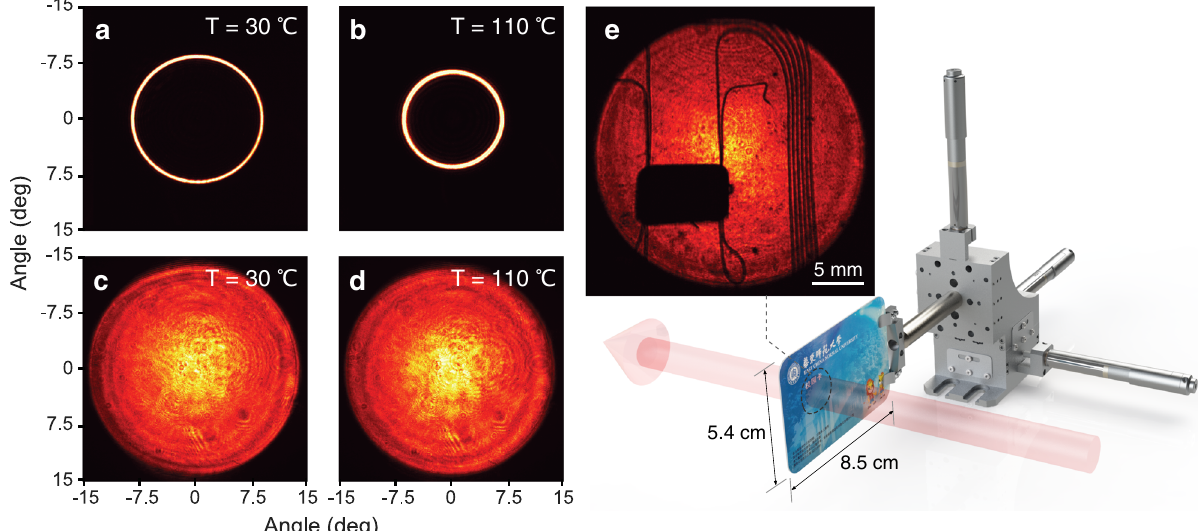
Fig. 4 Wide- fi eld MIR imaging performances. a , b Recorded fi eld of view for the conventional upconversion imaging with a PPLN at two different temperatures. c , d Wide- fi eld performance for the imaging scheme with a CPLN crystal, which indicates a robust immunity to the temperature variation. e Transmissive imaging for a campus ID card. The embedded chip and mental wires can be clearly identi fi ed. A video is recorded in Supplementary Movie